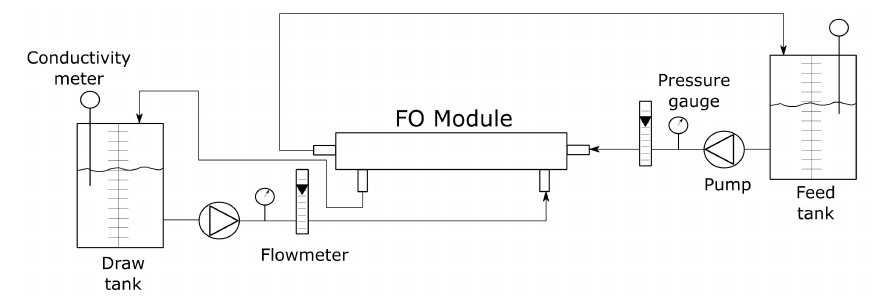
Figure 3. Schematic diagram of the forward osmosis (FO) laboratory